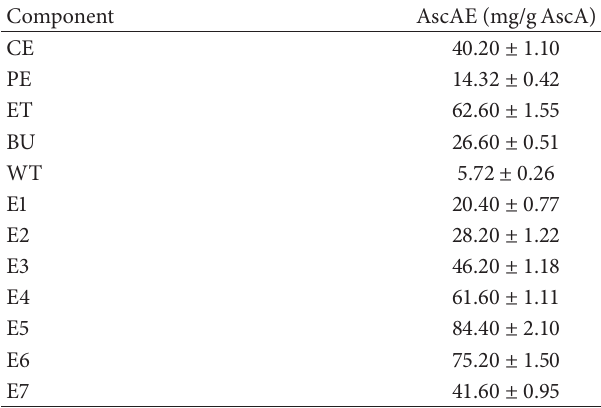
Table 5: Reducing power of extract and subcomponents E1–E7 isolated from